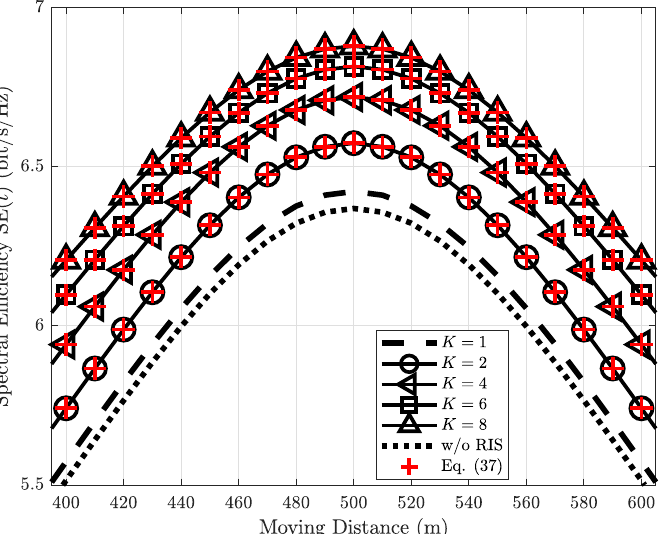
Figure 5. Spectral efficiency for different numbers of RIS. K = 1,2,4,6,8. Note that the analytical results are based on (37).